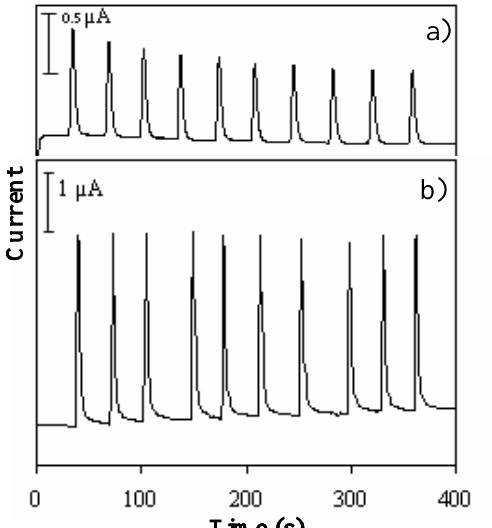
Figure 4. Examples of fouling (a) and anti-fouling (b) of BDD electrode for FI detection. Results were obtained from replicate injections of standard salbutamol 1x10 -5 M to the FI manifold in Fig. 2. (a) amperometric FI with detection potential fixed at 0.6 V. (b) pulsed amperometric FI with the optimized condition shown in Table